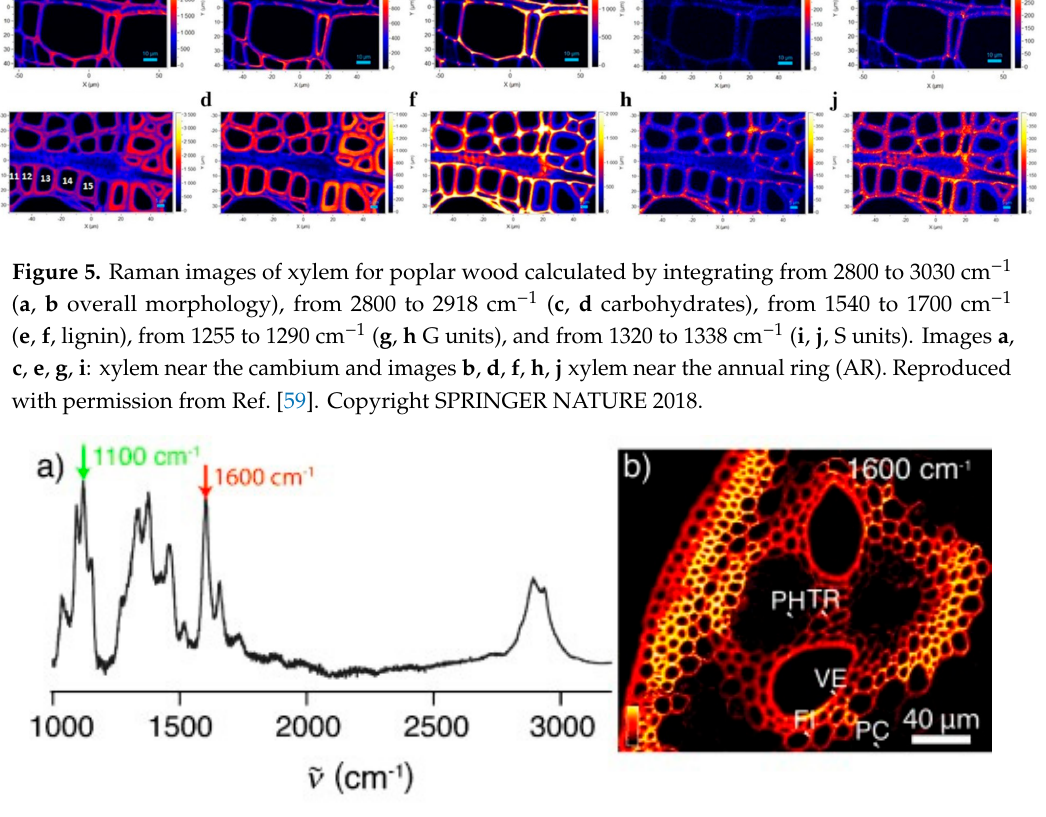
Figure 6. Raman spectrum and SRS imaging of corn stover. ( a ) Raman spectrum of raw corn stover. The peak at 1600 cm − 1 (red arrow) corresponds to the lignin distribution, and the peak at 1100 cm − 1 (green arrow) corresponds to cellulose. ( b ) SRS image of the vascular bundle including the edge of the stem in raw corn stover at 1600 cm − 1 , showing the lignin distribution. Labeled structures are discussed in the text: parenchyma (PC), phloem (PH), vessel (VE), tracheid (TR), fiber (FI). Reproduced with permission from Ref. [61]. Copyright JOHN WILEY AND SONS 2010.